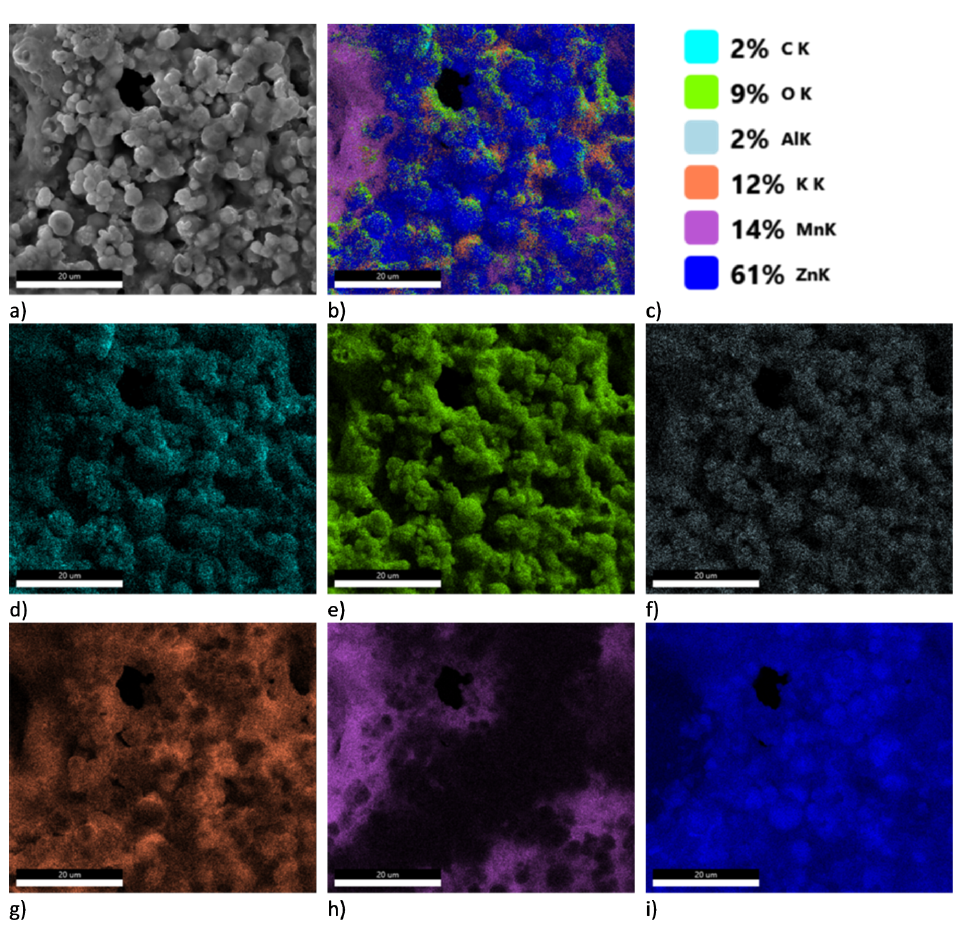
Figure A7. Result of SEM-EDS analysis for sample Zn7. ( a )—SEM picture; ( b )—EDS map; ( c )— weight concentration %; ( d )—EDS map for C; ( e )—EDS map for O; ( f )—EDS map for Al; ( g )—EDS map for K; ( h )—EDS map for Mn; ( i )—EDS map for